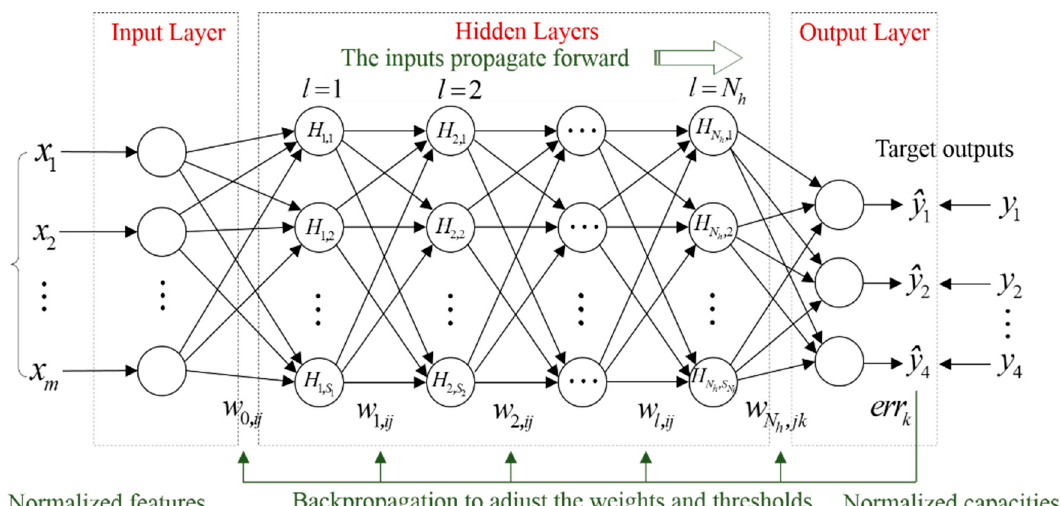
Figure 3. Architecture of the back propagation neural network (BPNN).